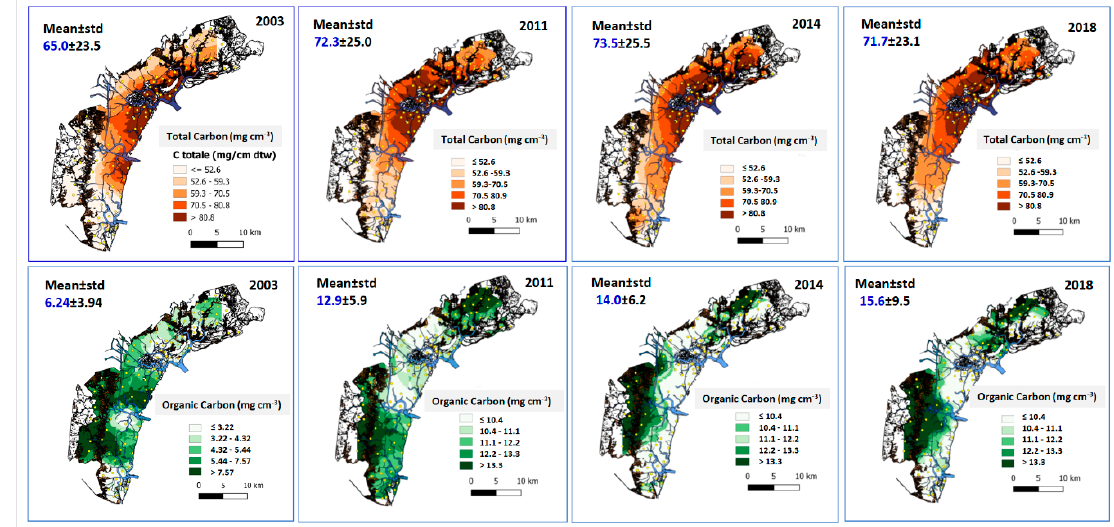
Figure 4. Distribution maps of Ctot and Corg in the surface sediments of the whole Venice